Question: Provide a publication-style caption for this figure.
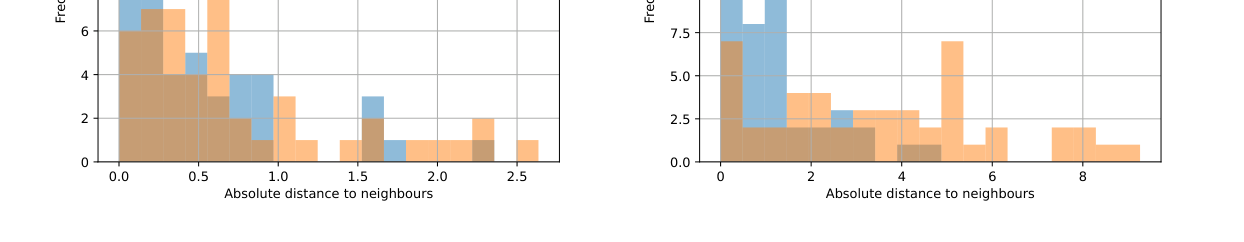
Answer: We investigate the difference between the loss of our unlearnt model (with GA and SGA) and a retrain-from-scratch proxy (proxy ‘data neighbours’ computed as shown in Appendix C). We do this for every sample in the forget set! Naturally, higher indistinguishability means much smaller distances (i.e., between 0 and 0.5 in our experiments on unseen data). The two figures show the loss distances of the forget set for the 125M and 1.3B checkpoints of GPT-Neo, aggregated across several forget sets/ unlearning runs.